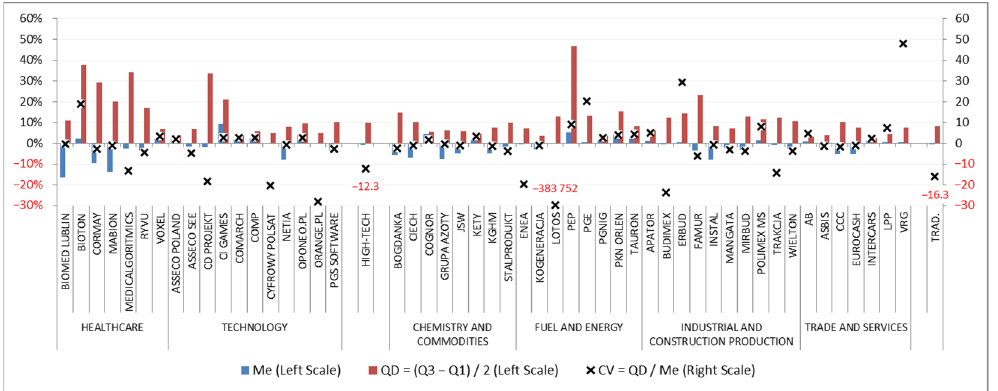
Figure 14. Assessment of total cost variation per unit of assets in the surveyed enterprises. Source: own work.